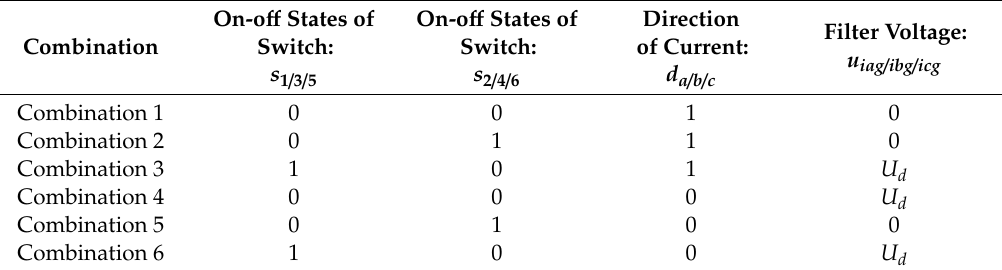
Figure 4. Voltages of phase A in di ff erent switching conditions and current directions under the healthy case. Table 1. Filter voltages under di ff erent on-o ff states and current